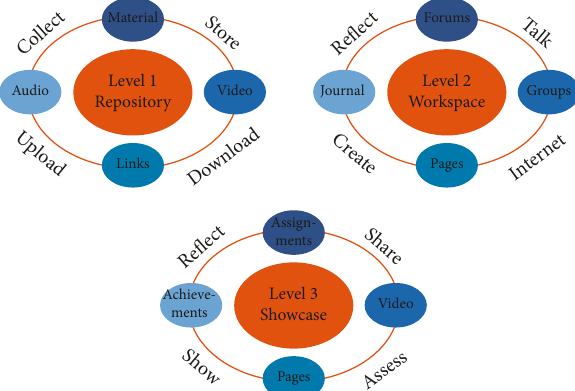
Figure 2: E-portfolio implementation guide for policymakers and practitioners adapted from EUfolio